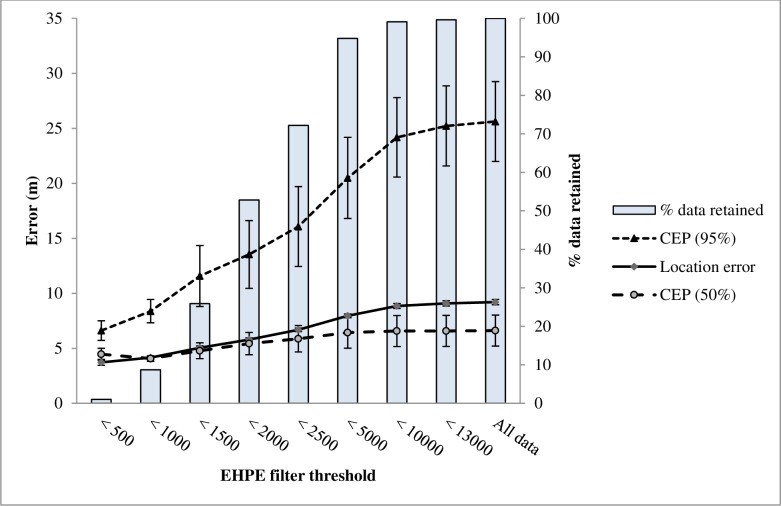
Mean location error (LE, ± SE) and 50 and 95% circular errors probable (CEP, ± SE) at 8 thresholds of estimated horizontal position error (EHPE) used to filter data, with percent data retained at each filter threshold.Data were collected by i–gotU GT–120 GPS loggers in Baker County, Georgia, USA in March and December, 2014 and October 2015.